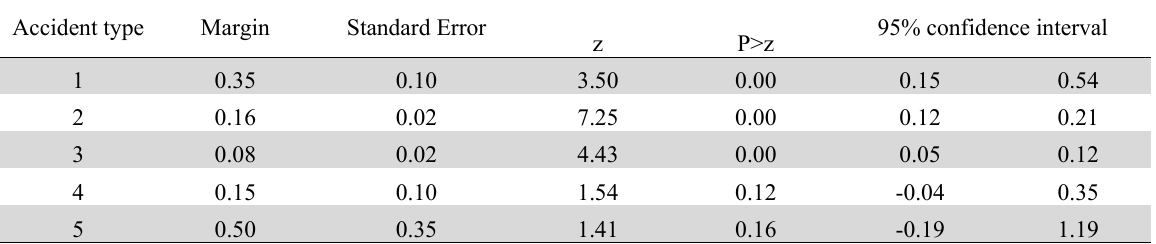
Quantile 3 dead people by accident type Accident